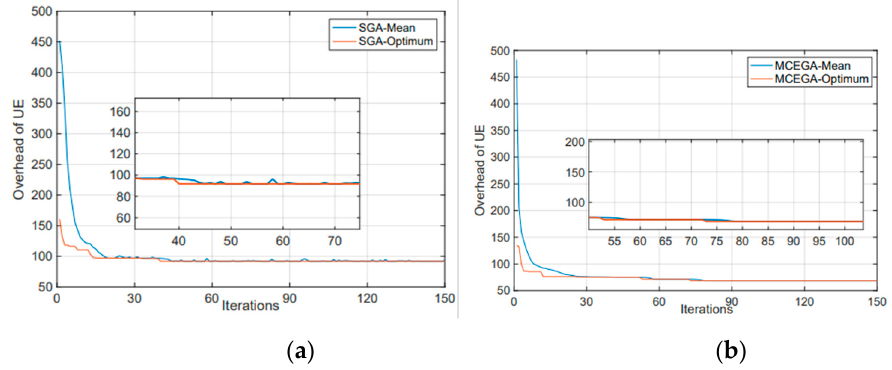
Figure 6. The convergence situation of MCEGA ( b ) and Standard genetic algorithm (SGA) ( a ).